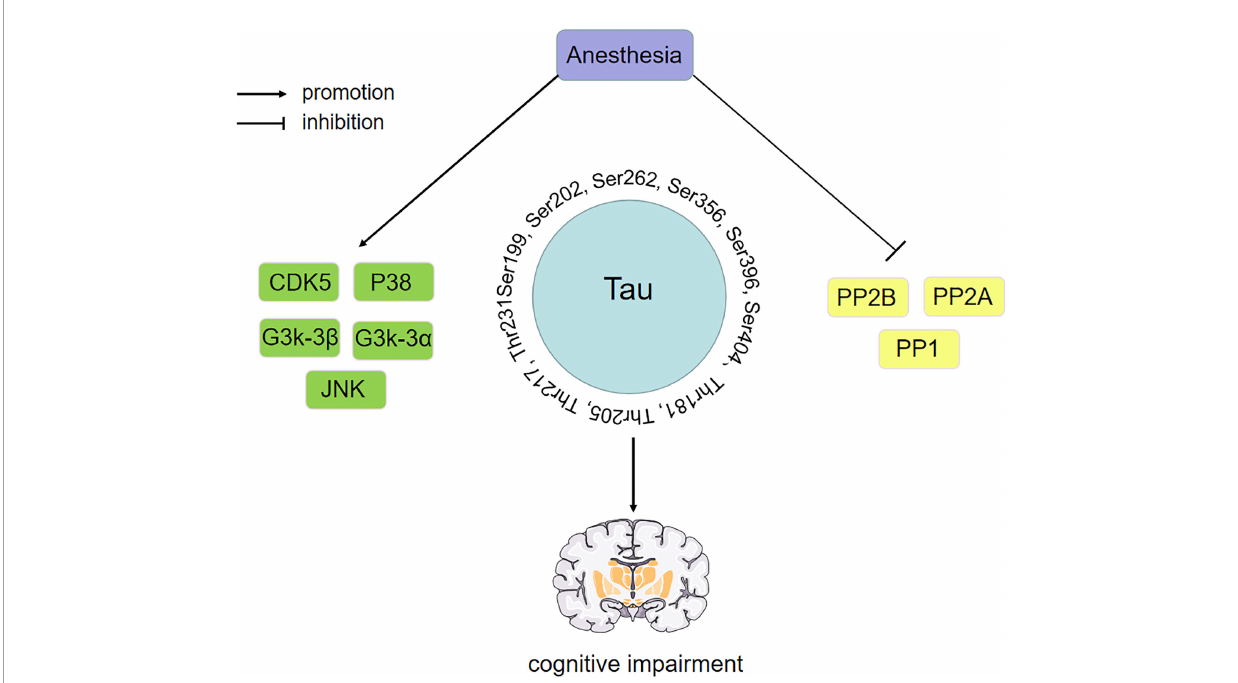
FIGURE4 Anesthetic drugs-kinase/phosphatase-p-Tau-cognitive impairment. Key kinase/phosphatase includes GSK-3 β , GSK-3 α , CDK5, P38, JNK, PP1, PP2A, and PP2B. The phosphorylation sites of key tau include Ser199, Ser202, Ser262, Ser356, Ser396, Ser404, Thr181, Thr205, Thr217, and Thr231. The effect of anesthetic drugs on cognitive dysfunction through tau may be the result of the balance between various kinases and phosphatases. PP2A, protein phosphatase 2A; PP2B, protein phosphatase 2B; PP1, protein phosphatase 1; CDK5, cyclin-dependent kinase 5; GSK-3 α , glycogen synthase kinase-3 α ; GSK-3 β , glycogen synthase kinase-3 β ; JNK, c-Jun NH2-terminal